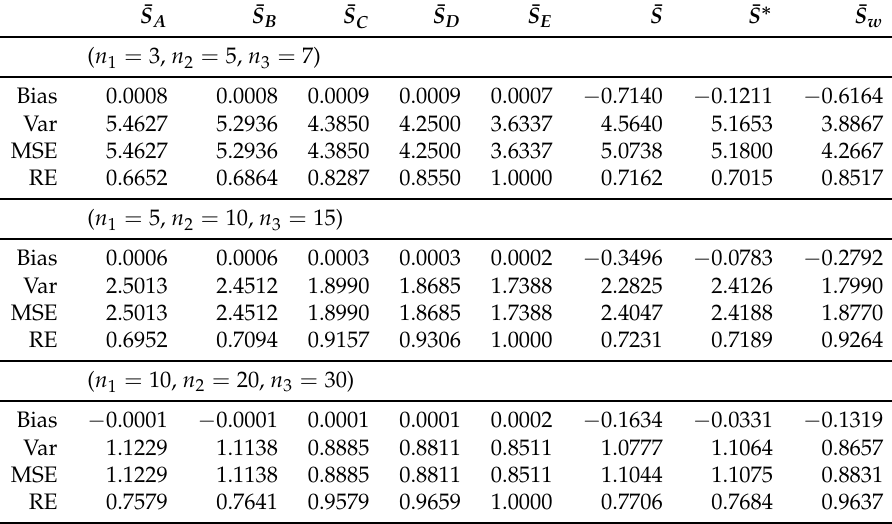
Table 2. The empirical bias, variance, MSE, and RE with unequal sample